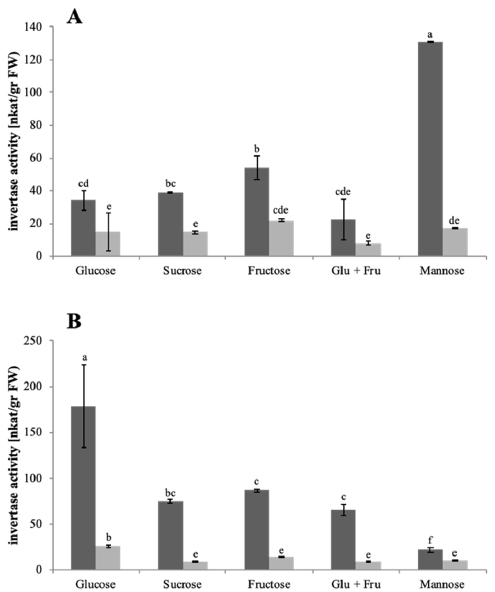
Figure 3. Extracellular invertase activities. S. indica ( A ) and S. herbamans ( B ) were grown in liquid cultures with different sugar sources. Culture supernatant was harvested, proteins were extracted and invertase activities were measured at pH 4.5 (dark grey columns) or at pH 6.8 (light grey col- umns). Mean values are shown with standard errors as bars. Significant differences of growth pa- rameters between different sugar sources and different pH are indicated by different letters above the columns (two-way ANOVA Tukey Test; n = 3).